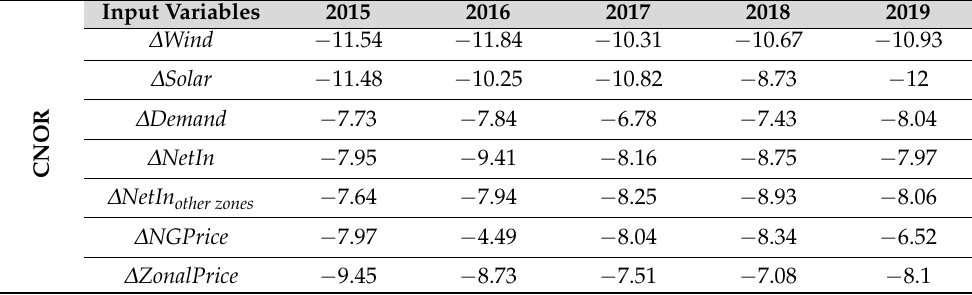
Table A1. Augmented Dickey–Fuller test statistics in 1st difference; CNOR.